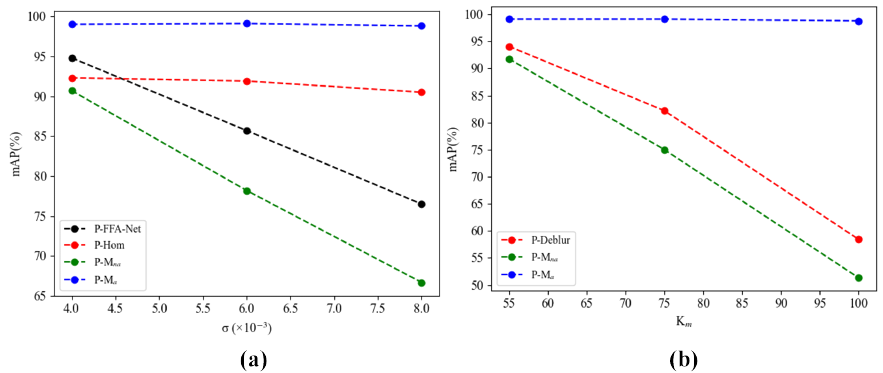
Figure 15. Performance of the pre-processed blurred images. ( a ) Performance of the fog-blurred images pre-processed by homomorphic filter [21] and FFA-Net [22]. ( b ) Performance of the motion- blurred images pre-processed by DeblurGAN [23].